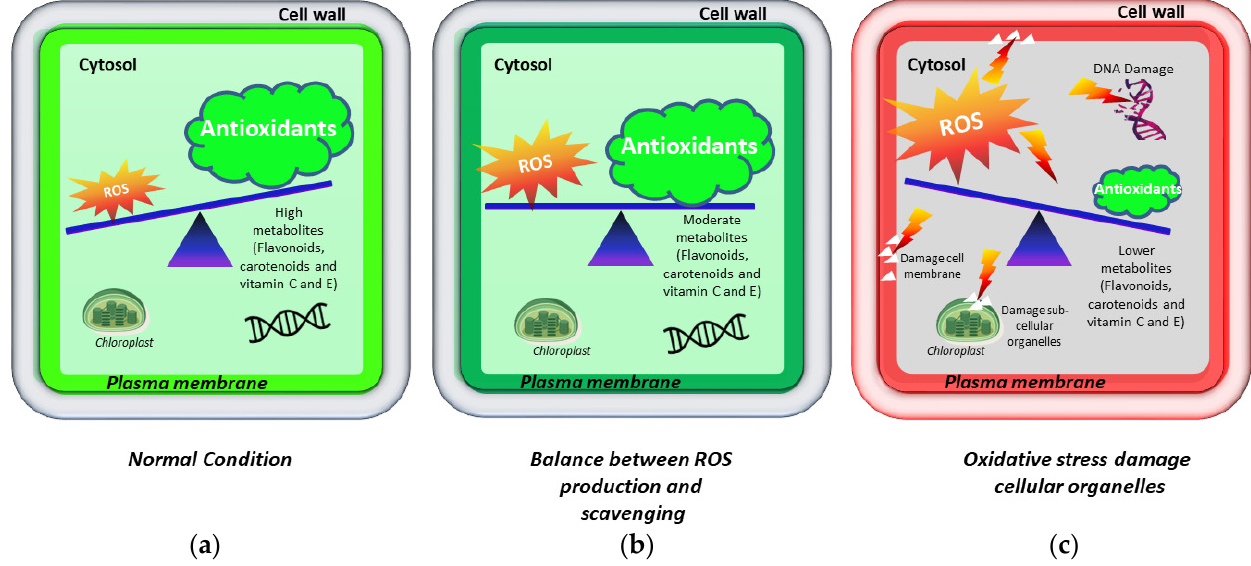
Figure 1. The role of antioxidant metabolites and reactive oxygen species (ROS) in normal and oxidative stress conditions. ( a ) High levels of antioxidant metabolites such as flavonoids can protect cellular organelles. ( b ) Under mild stress condition, the moderate level of antioxidant metabolites can detoxify ROS, which can maintain the balance between the production and scavenging of ROS. ( c ) Under high oxidative stress, the level of ROS is increased while that of antioxidant metabolites is reduced, which damages the membranes, DNA, proteins, and other cellular organelles, finally leading to cell death.